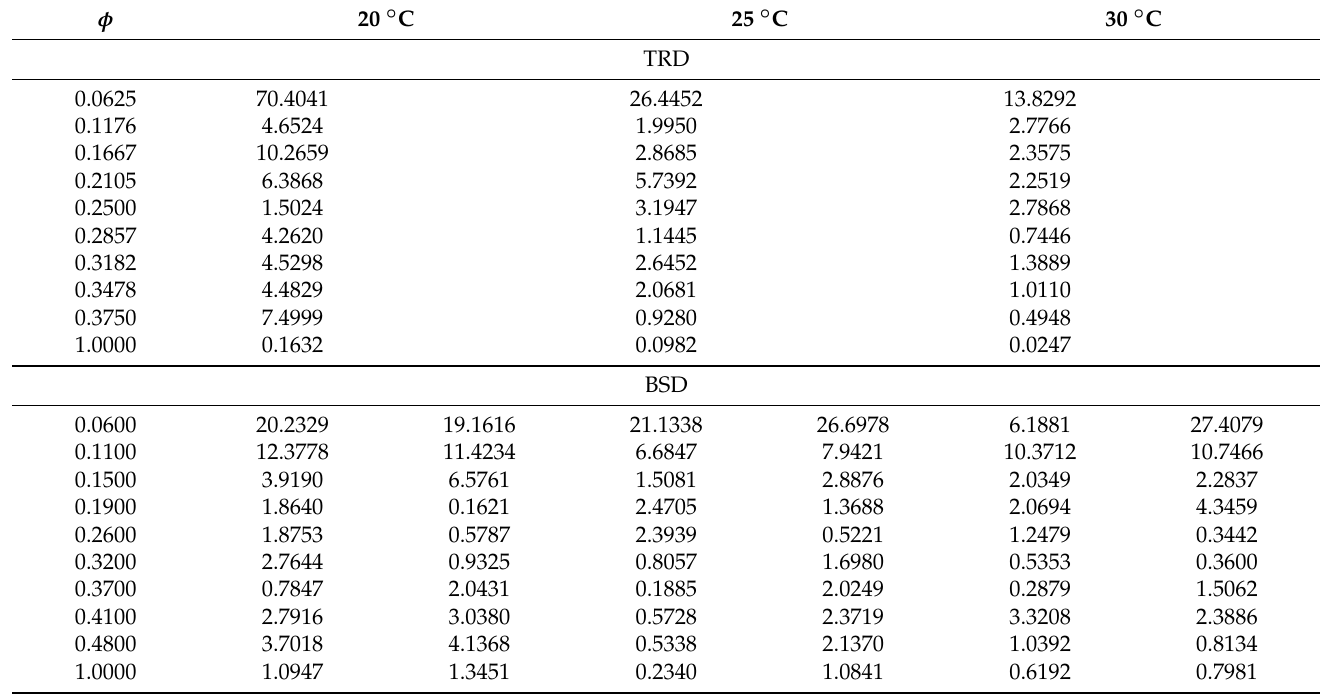
Table A2. Percentage relative errors ( e ) in the measurement of the water volume fraction ( φ ) in the emulsion using the calibration curve provided by the Equation (6) for both BSD and TRD and the three test temperatures. In the BSD case, results are reported for two